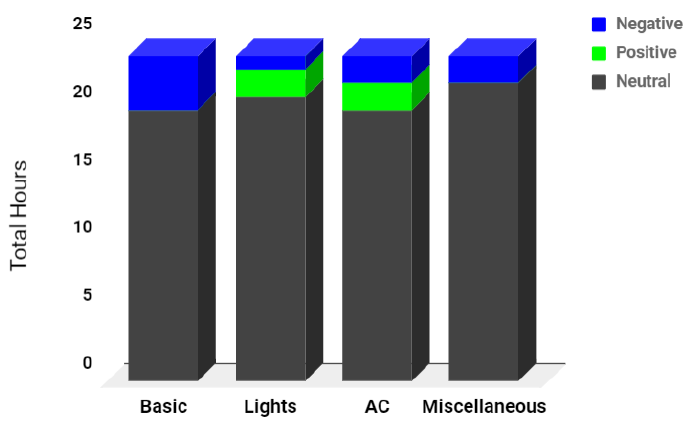
Figure 7. Distribution of hours for